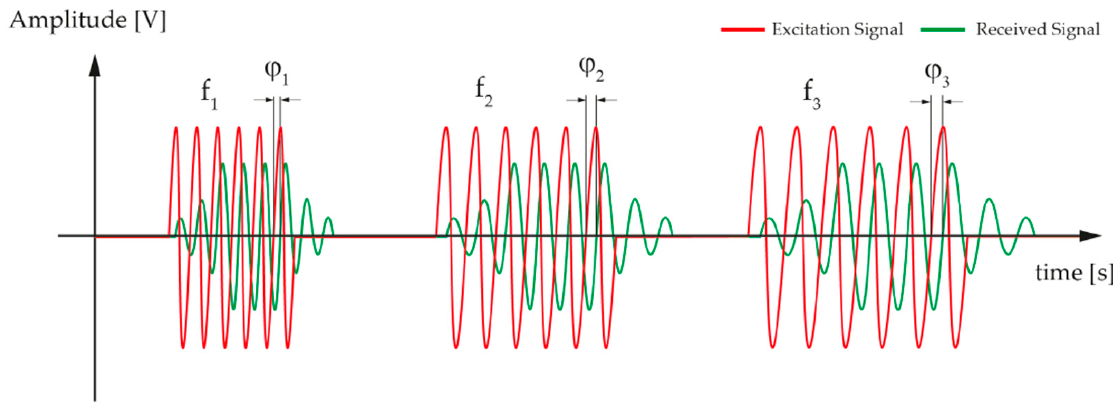
Figure 19. Illustration of the MFPW method. Reproduced with permission from [46], Copyright 2021, MDPI AG.